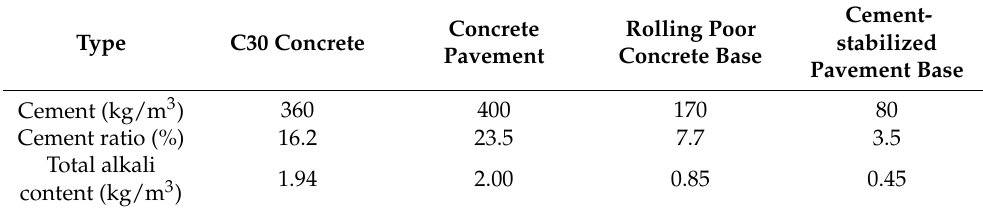
Table 9. Total alkali content of various